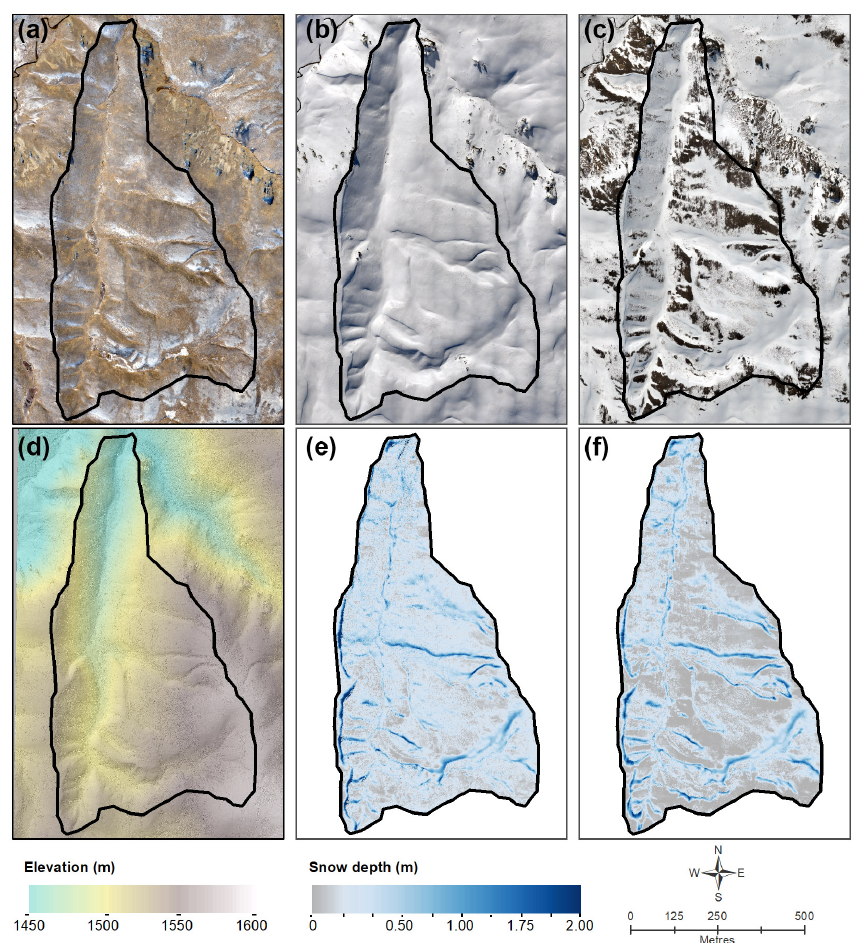
Figure 3. Processed ortho-mosaics for autumn (a) , winter (b) and spring (c) flights, with corresponding autumn hill-shaded DSM (d) and maps of snow depth derived for winter (e) and spring (f) .